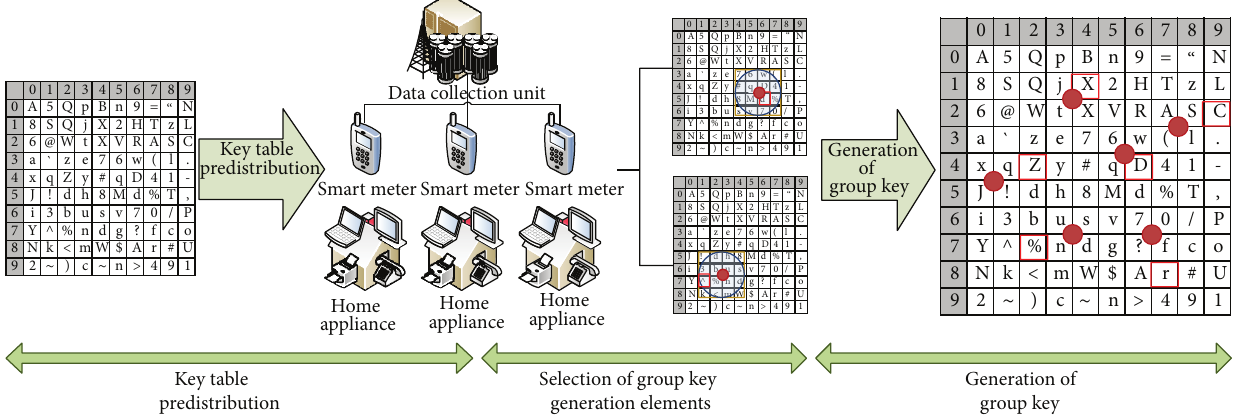
Selection of group key generation elements Figure 4: Basic structure of proposed